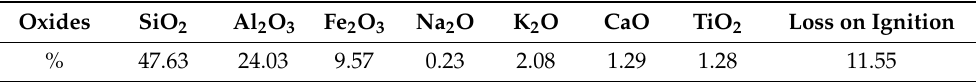
Table 1. Chemical composition of Saudi red clay (wt%).